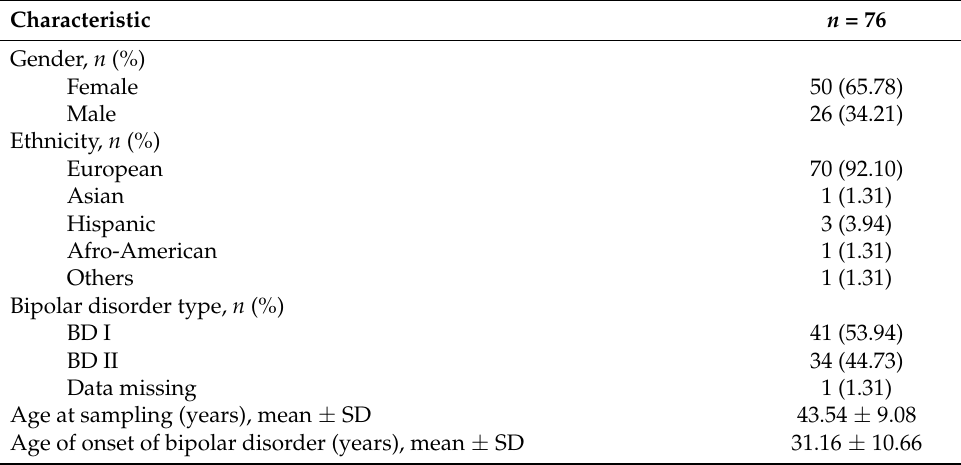
Table 1. Demographic and clinical characteristics of the study